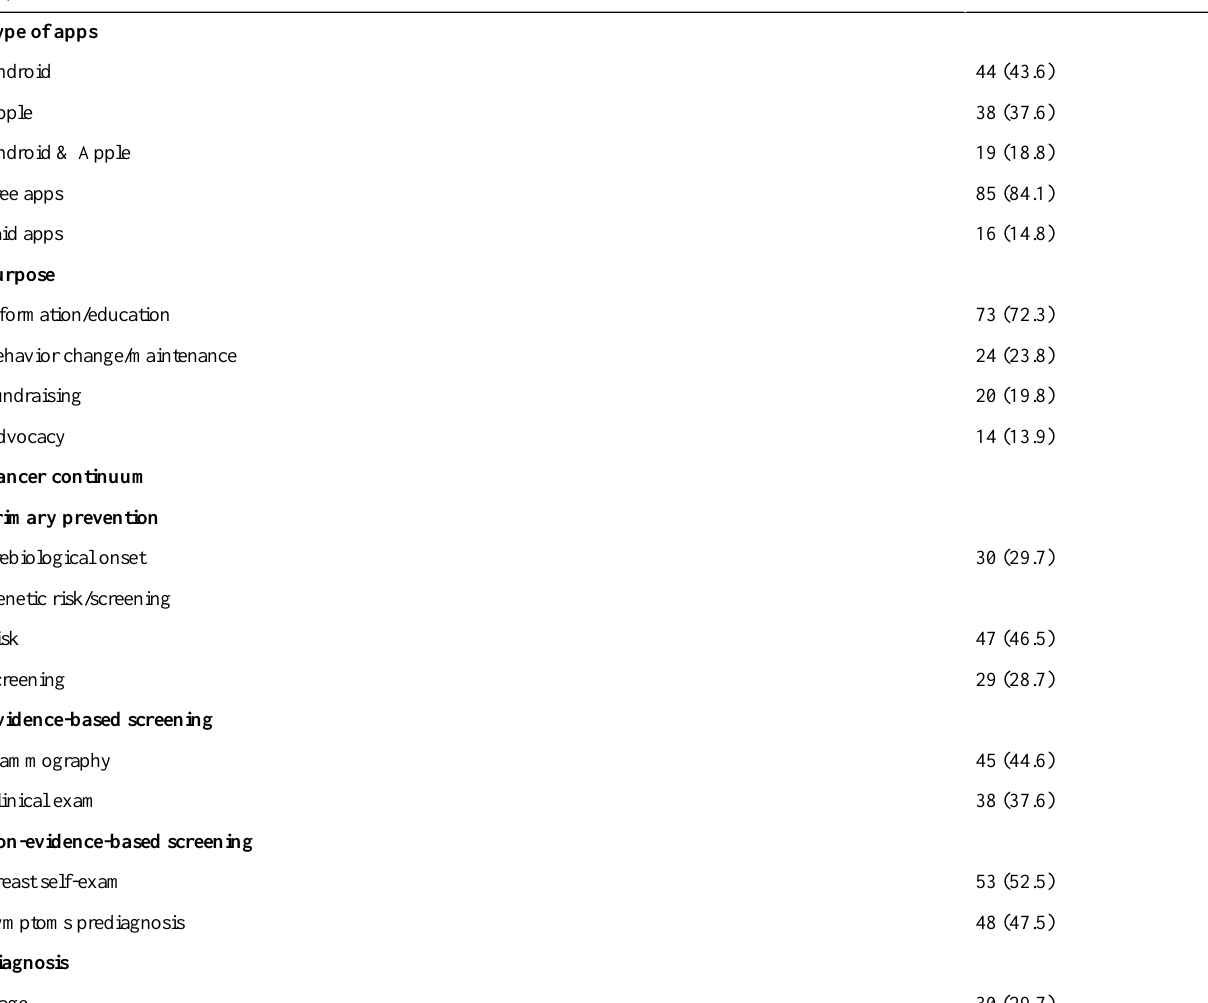
Table 2. Characteristics of breast cancer-related apps on the App Store and Google Play